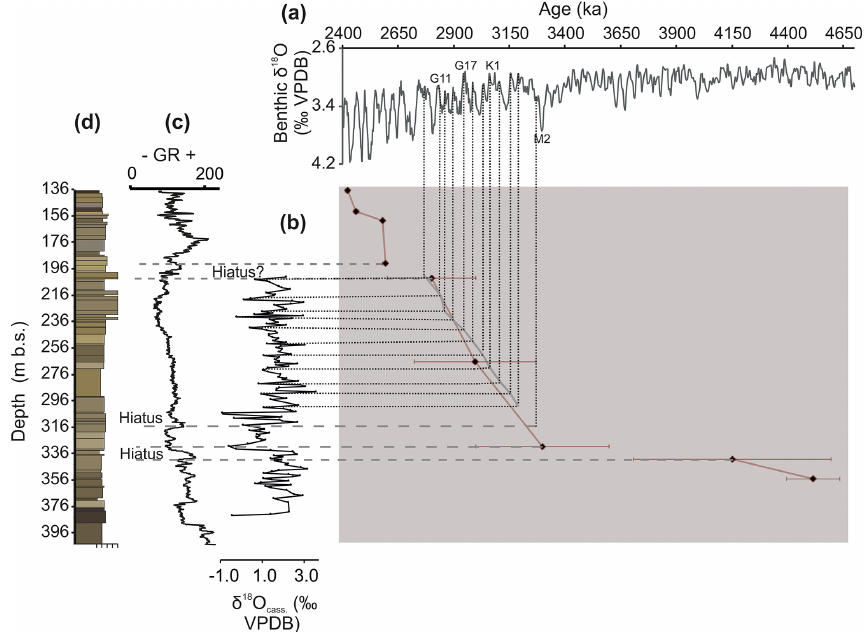
Figure 5. Age framework for the Pliocene southern North Sea basin. Correlations of the interglacials of the (a) LR04 stack (Lisiecki and Raymo, 2005) to the interglacials in the (b) δ 18 O cass . record for Hank. (c) Smoothed gamma ray (GR) and (d) lithology, and depth of Hank sediments. Dotted grey lines indicate tie points based on δ 18 O values, whereas the dashed line at ∼ 314m is based on correlation of sequence boundary with the Poederlee Formation (De Schepper et al., 2009a; Louwye and De Schepper, 2010). Biostratigraphic age estimates (Dearing Crampton-Flood et al., 2018) are shown as black